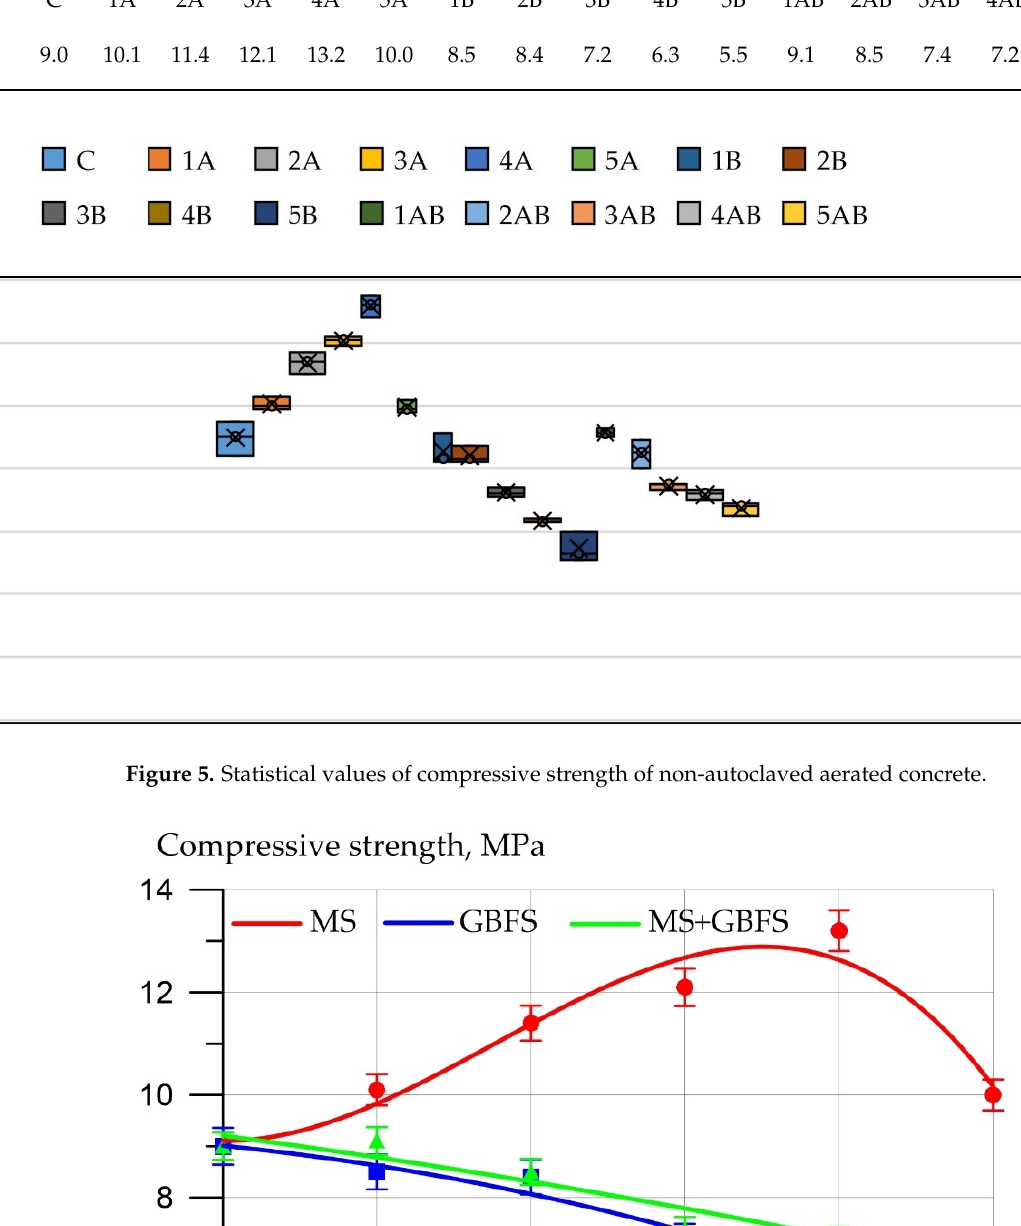
Table 9. Experimental values of compressive strength of non-autoclaved aerated concrete.